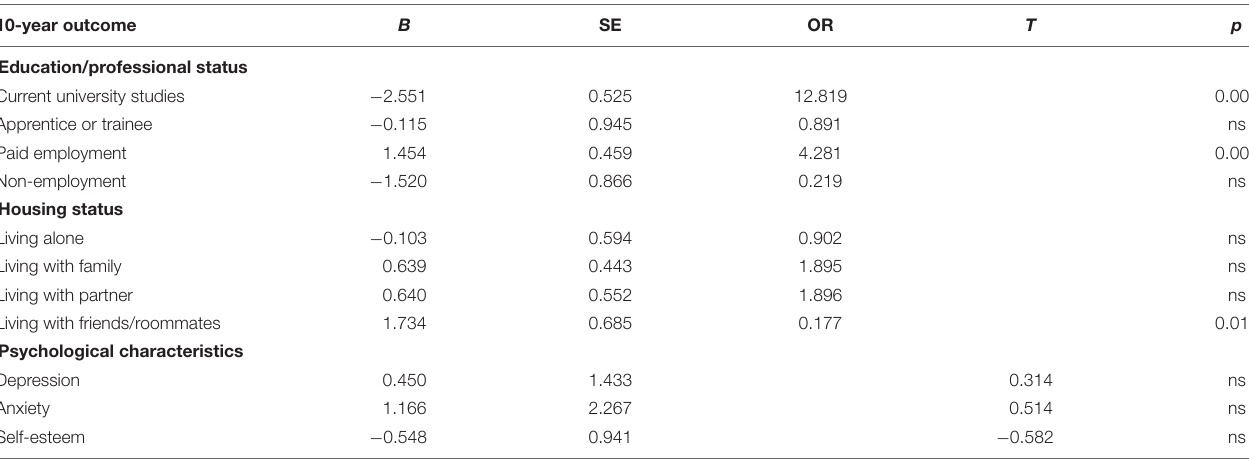
TABLE 2 | Baseline academic difficulty (versus academic success) as a predictor of 10-year outcomes ( n =